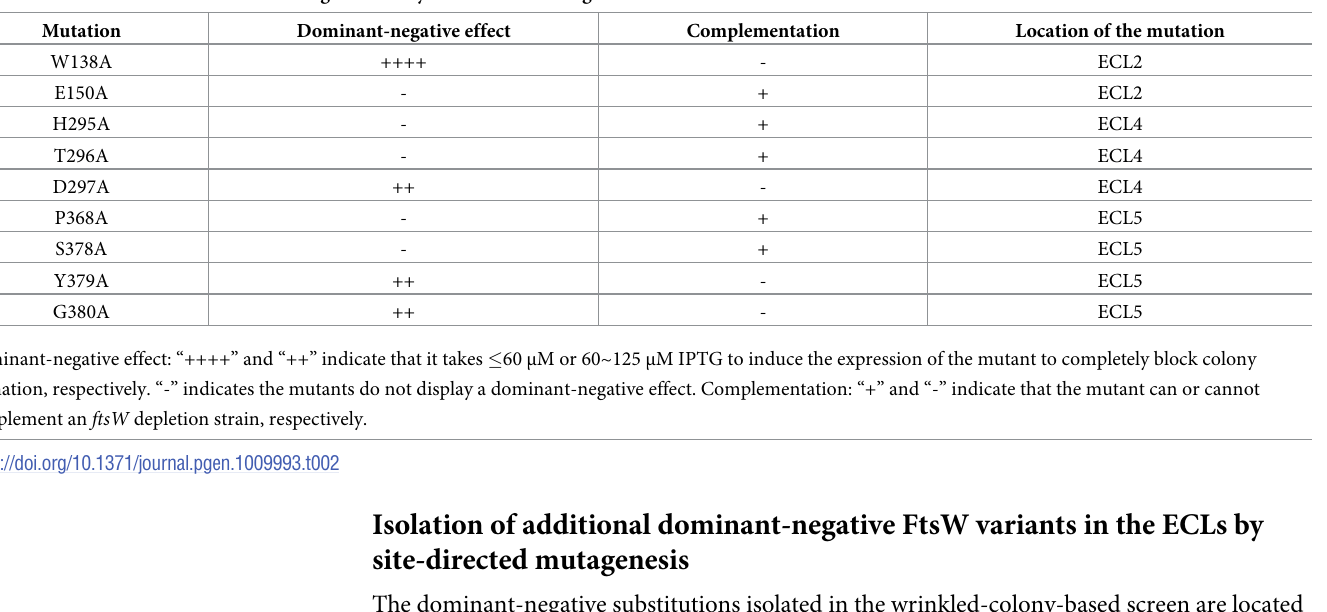
Table 2. Amino acid substitutions in FtsW generated by site-directed mutagenesis.